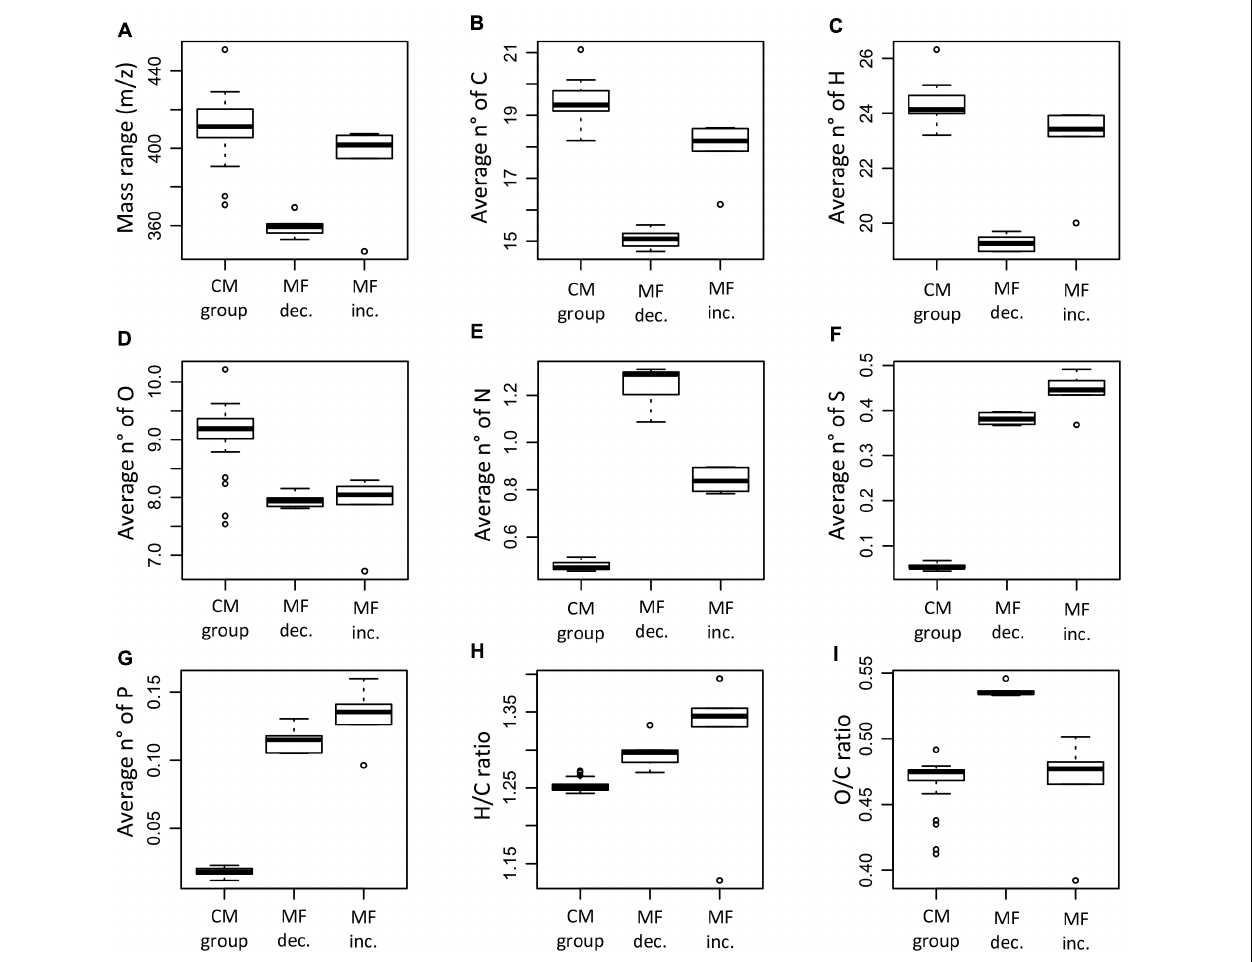
FIGURE 9 | Box plots summarizing and comparing the average mass range (A) , number of carbon (B) , hydrogen (C) , oxygen (D) , nitrogen (E) , sulfur (F) , phosphorus (G) , H/C ratio (H) , and O/C ratio (I) of the molecular formulae that significantly decreased (MF dec., n = 315), the molecular formulae that significantly increased (MF inc., n = 254), and the molecular formulae in the conservative mixing group (CM group, n = 13,462). The information corresponds to the averages weighted by FT-ICR-MS signal intensity for each of the